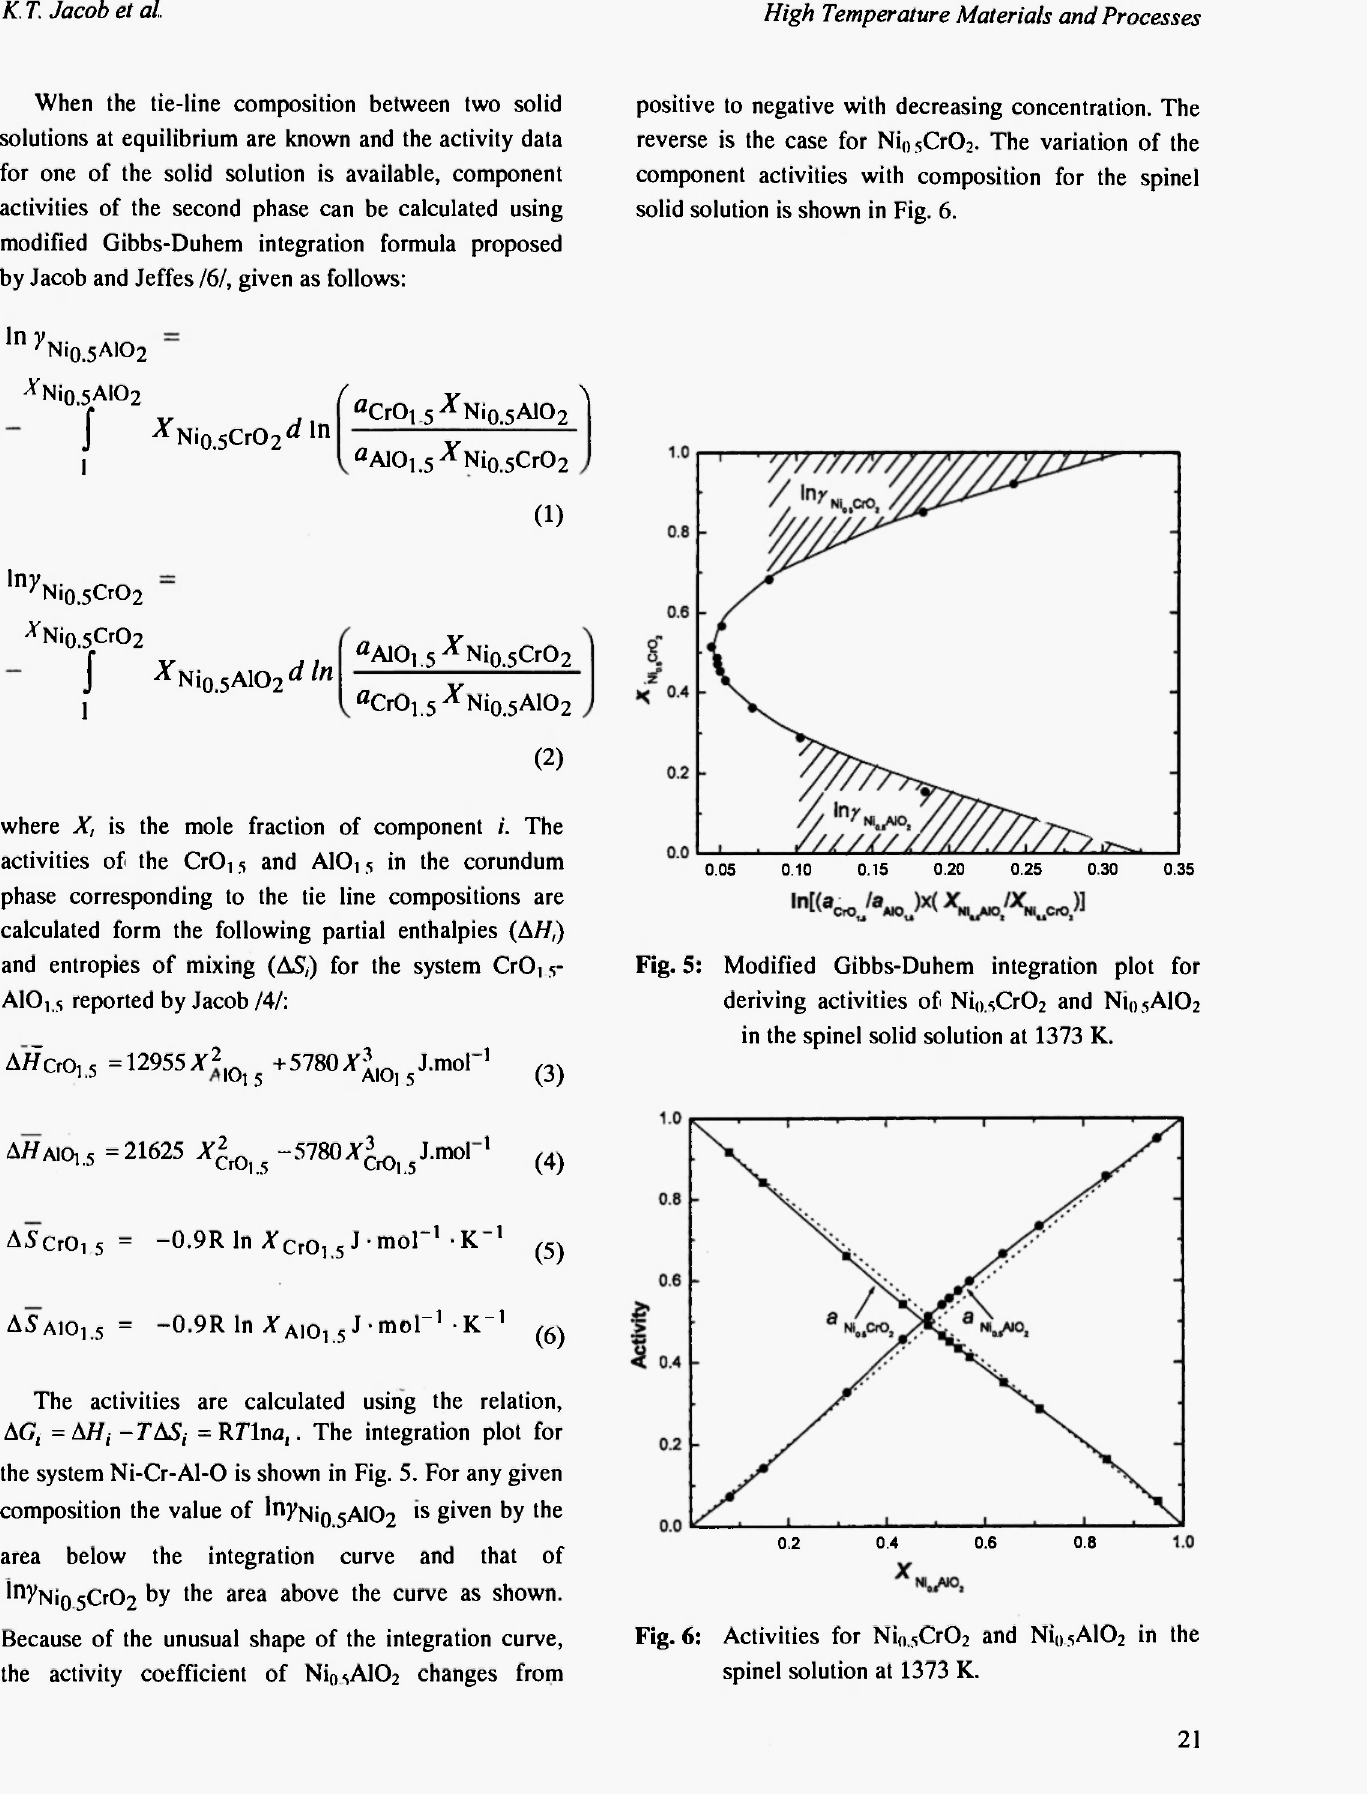
Fig. 5: Modified Gibbs-Duhem integration plot for deriving activities of Ni 0 .<;CrO 2 and N105AIO2 in the spinel solid solution at 1373 K.